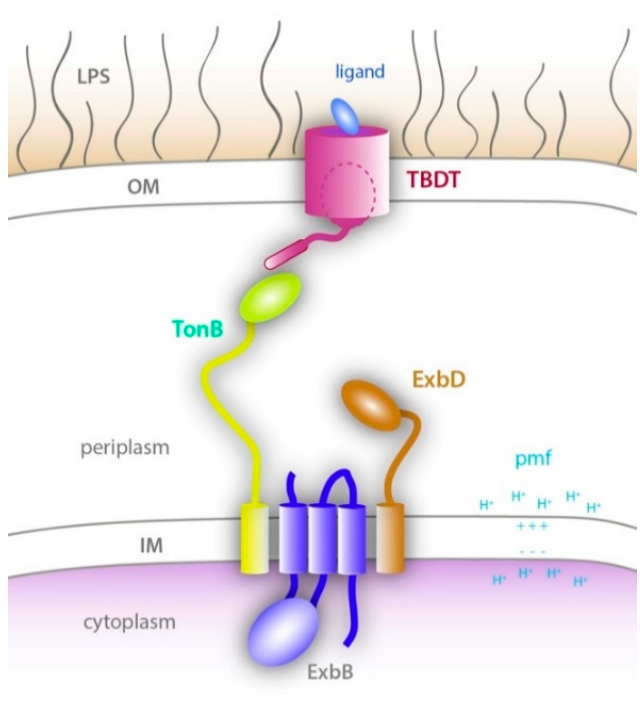
Figure 1. Energy transduction by the Ton system. (adapted from [7]) A schematic of the Ton system which consists of an energy generating and transducing complex located in the inner membrane called the Ton complex (ExbB, ExbD, and TonB), and a TonB-dependent transporter (TBDT) at the outer membrane. Upon ligand binding to the TBDT, TonB interacts with the TonB box of the TBDT. Energy produced by the Ton complex using the pmf is then used to partially unfold or eject the plug domain of the TBDT (dashed oval) to allow ligand import across the outer membrane.